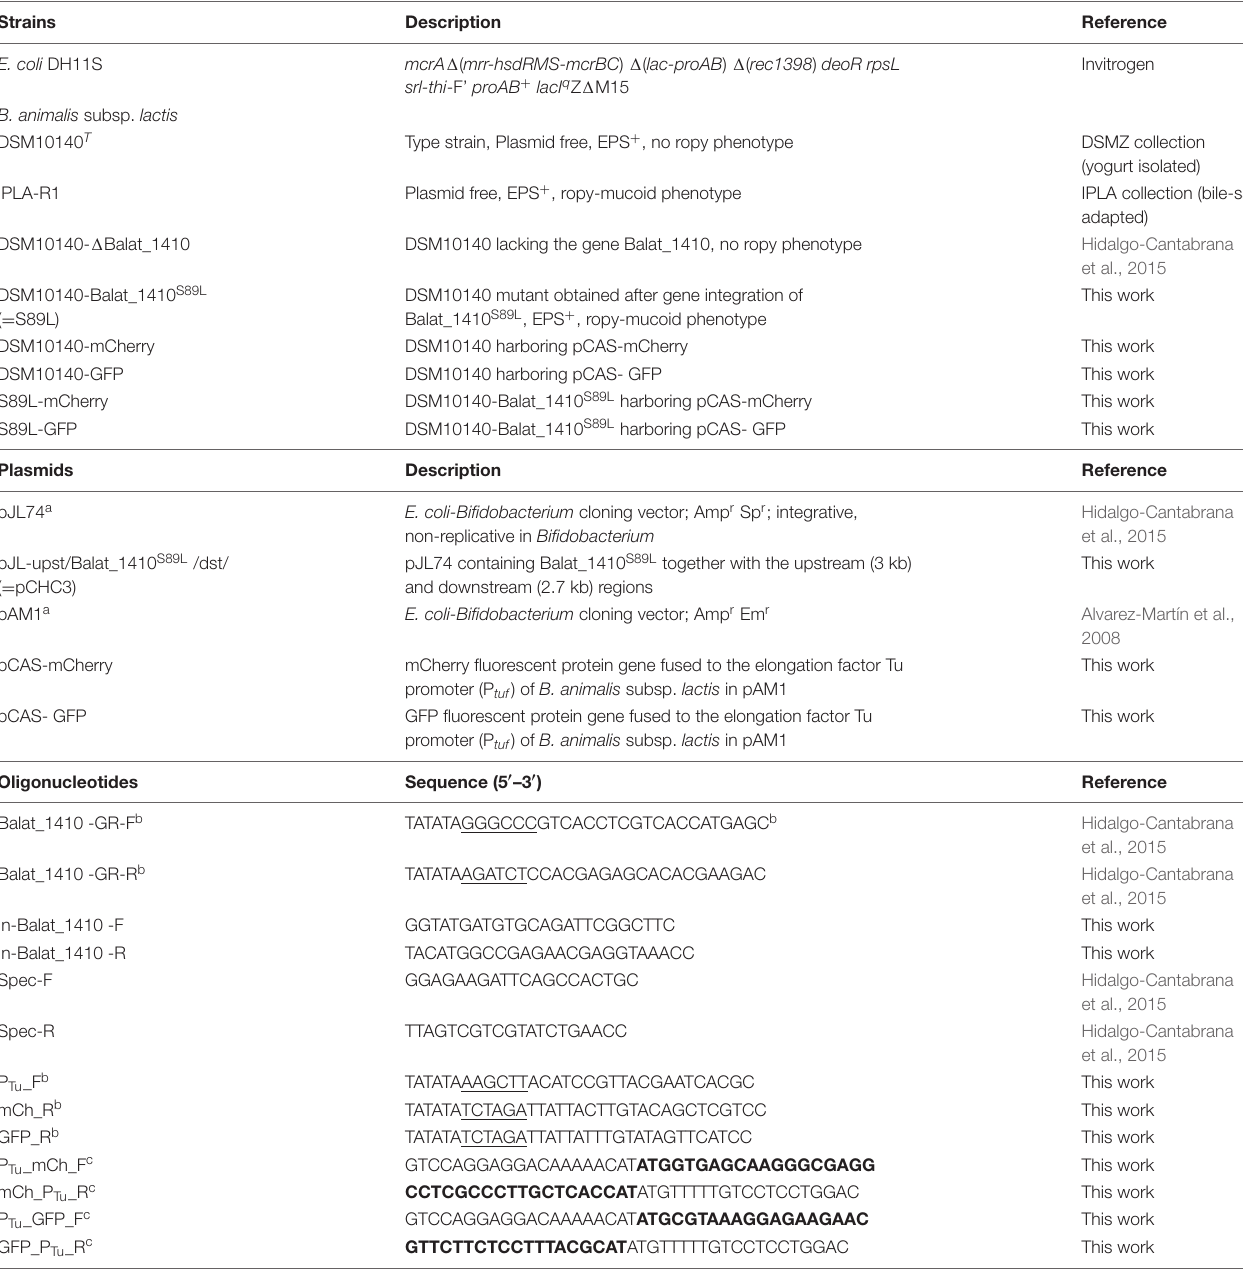
TABLE 1 | Bacterial strains, plasmids, and oligonucleotide primers used in this study.